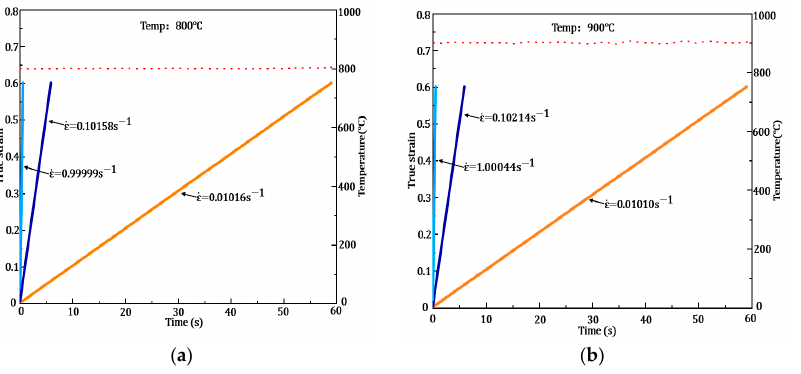
Figure 6. Verification of strain rates and temperatures using Gleeble tensile testing: ( a ) 800 °C; ( b ) 900 °C. 4.2. Calibration of the Angle, 𝛼 (cid:3036) , Evolution in the Non-Uniformity Zone